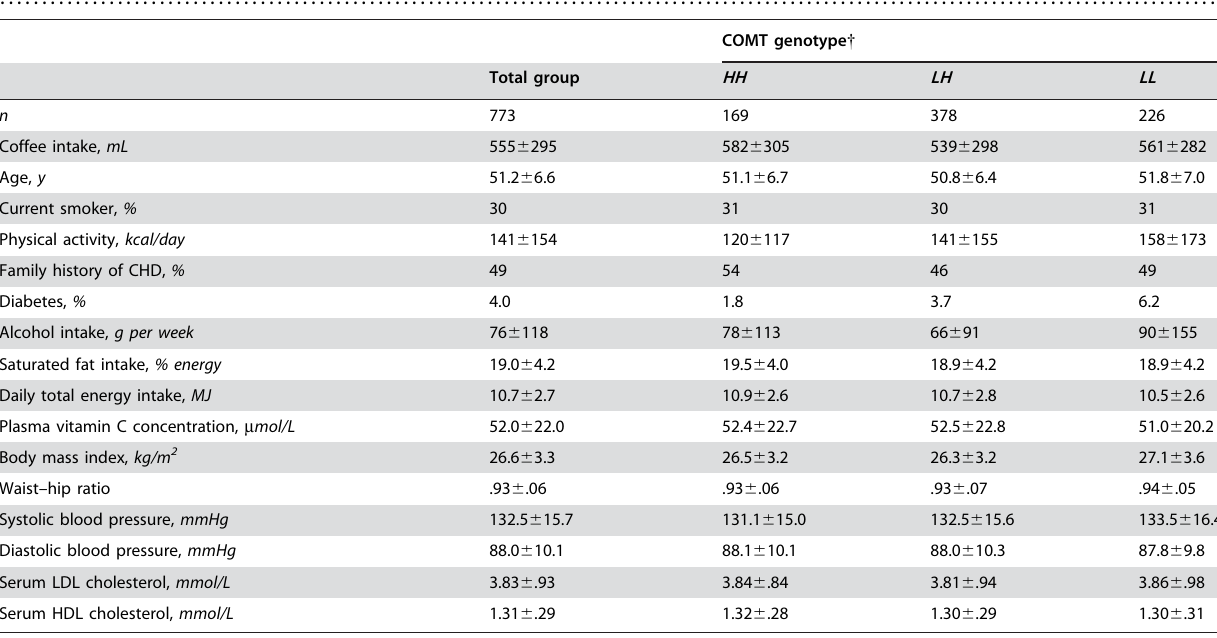
Table 2. Characteristics of the study participants, according to their COMT genotype.* .. ... .... ... ... .... ... ... .... ... ... .... ... ... .... ... ... .... ... ... .... ... ... .... ... ... .... ... ... .... ... ... .... ... ... .... ... ... .... ... ... .... ... ...